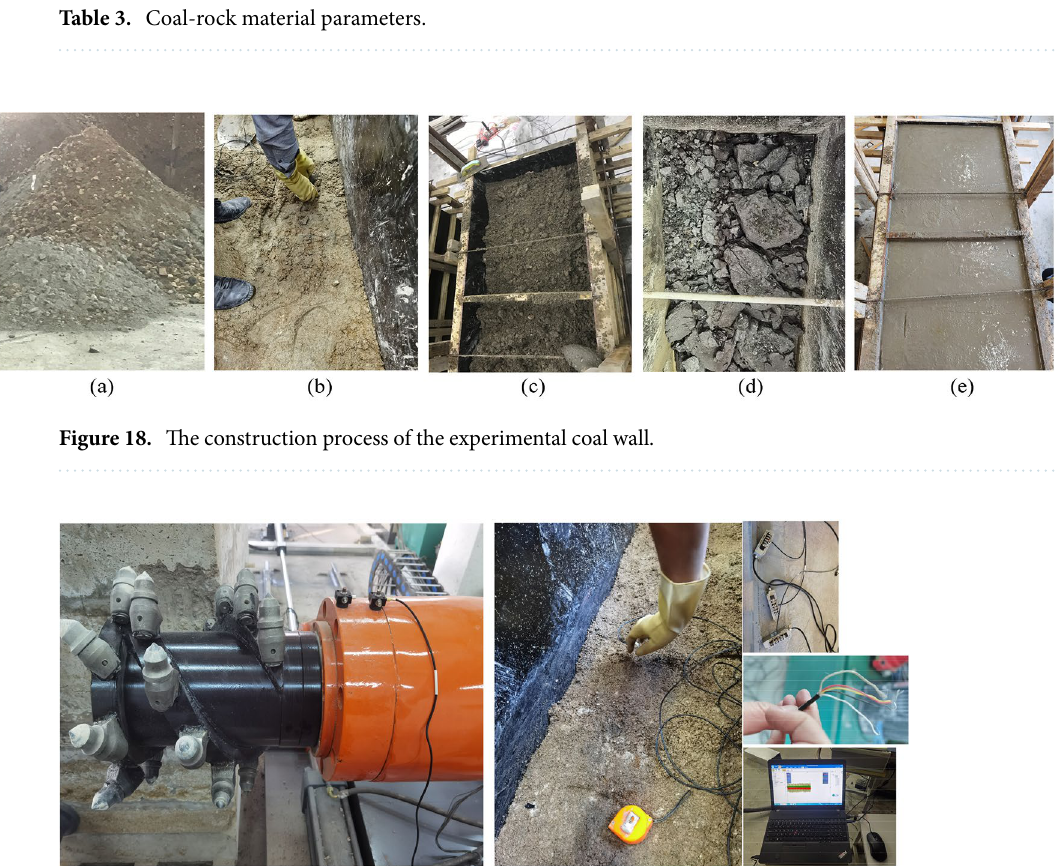
Table 3. Coal-rock material parameters.